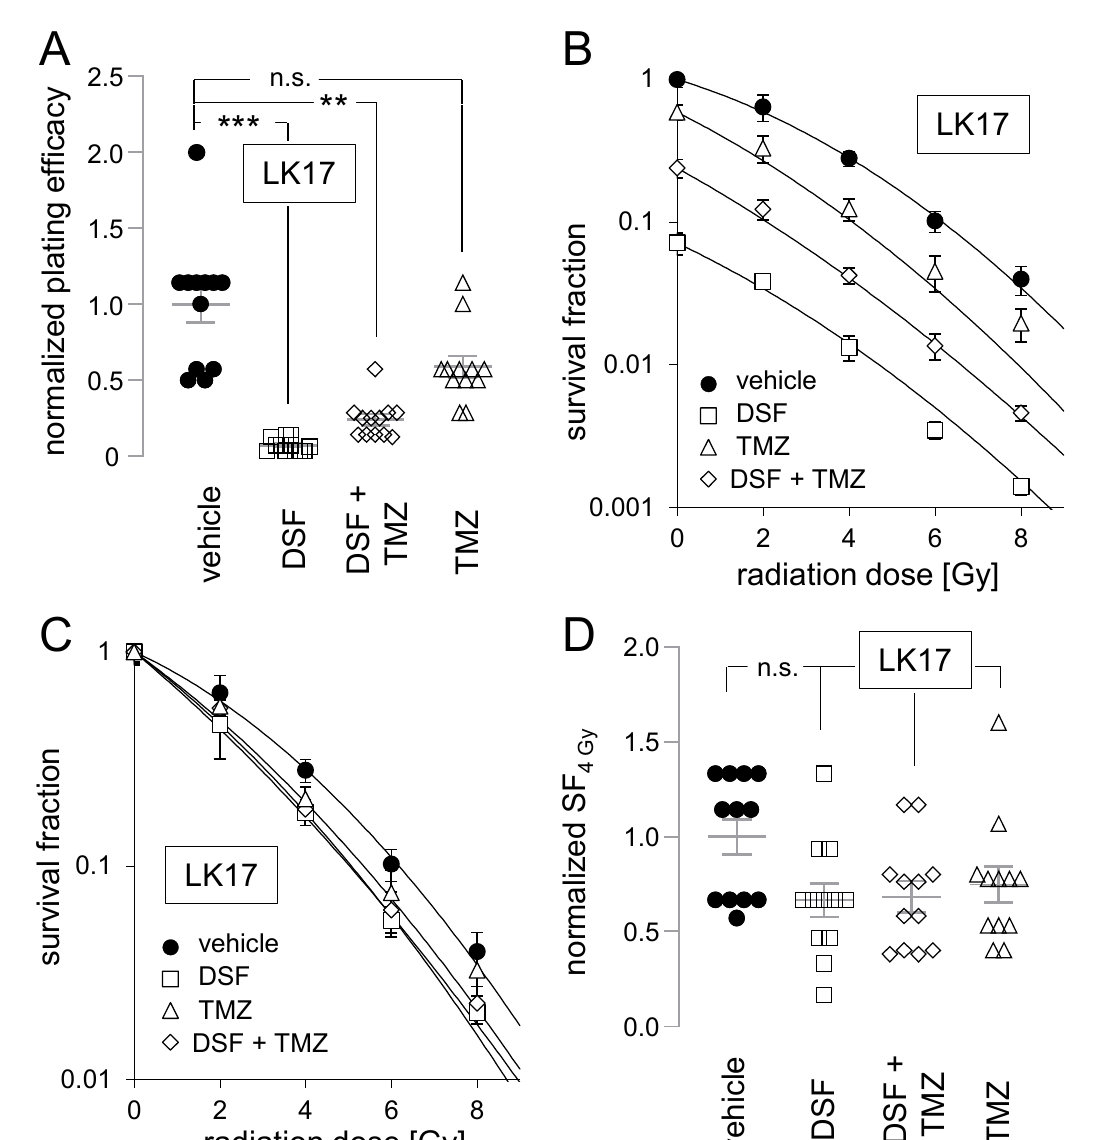
Figure 7. Disulfiram impairs clonogenic survival of LK17 cells. Neither disulfiram nor temozolomide radiosensitizes LK17 cells. ( A – D ). Dependence of normalized plating efficiency ( A ), vehicle-0 Gy control-normalized survival fraction ( B ), experimental arm-specific 0 Gy control-normalized survival fraction ( C ), and survival fraction after irradiation with 4 Gy (SF 4 Gy , ( D )) of LK17 cells on radiation dose (in ( B , C )) and on cotreatment (in ( A – D )) with vehicle (closed circles), disulfiram (DSF, 100 nM, open squares), temozolomide (TMZ, 30 µ M, open triangles) and DSF + TMZ (open diamonds). Shown are means ( ± SE, n = 12) and additionally individual values in ( A , D ). Mean ( ± SE, n = 12) absolute plating efficiency of 0 Gy/vehicle-treated LK17 cells was 0.75 ± 0.09. **, *** and n.s. indicate p ≤ 0.01, p ≤ 0.001, and not significantly differing, respectively, as calculated by nonparametric Kruskal–Wallis with Dunn’s multiple comparison test.